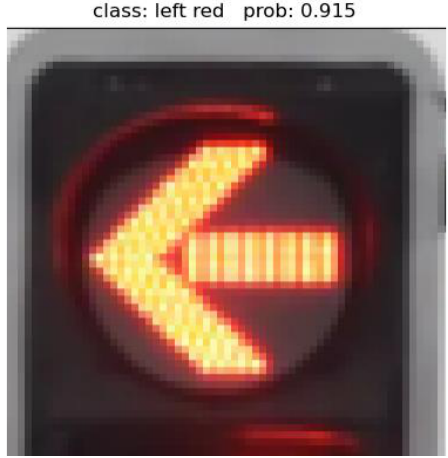
Figure 18. Validation result 1.